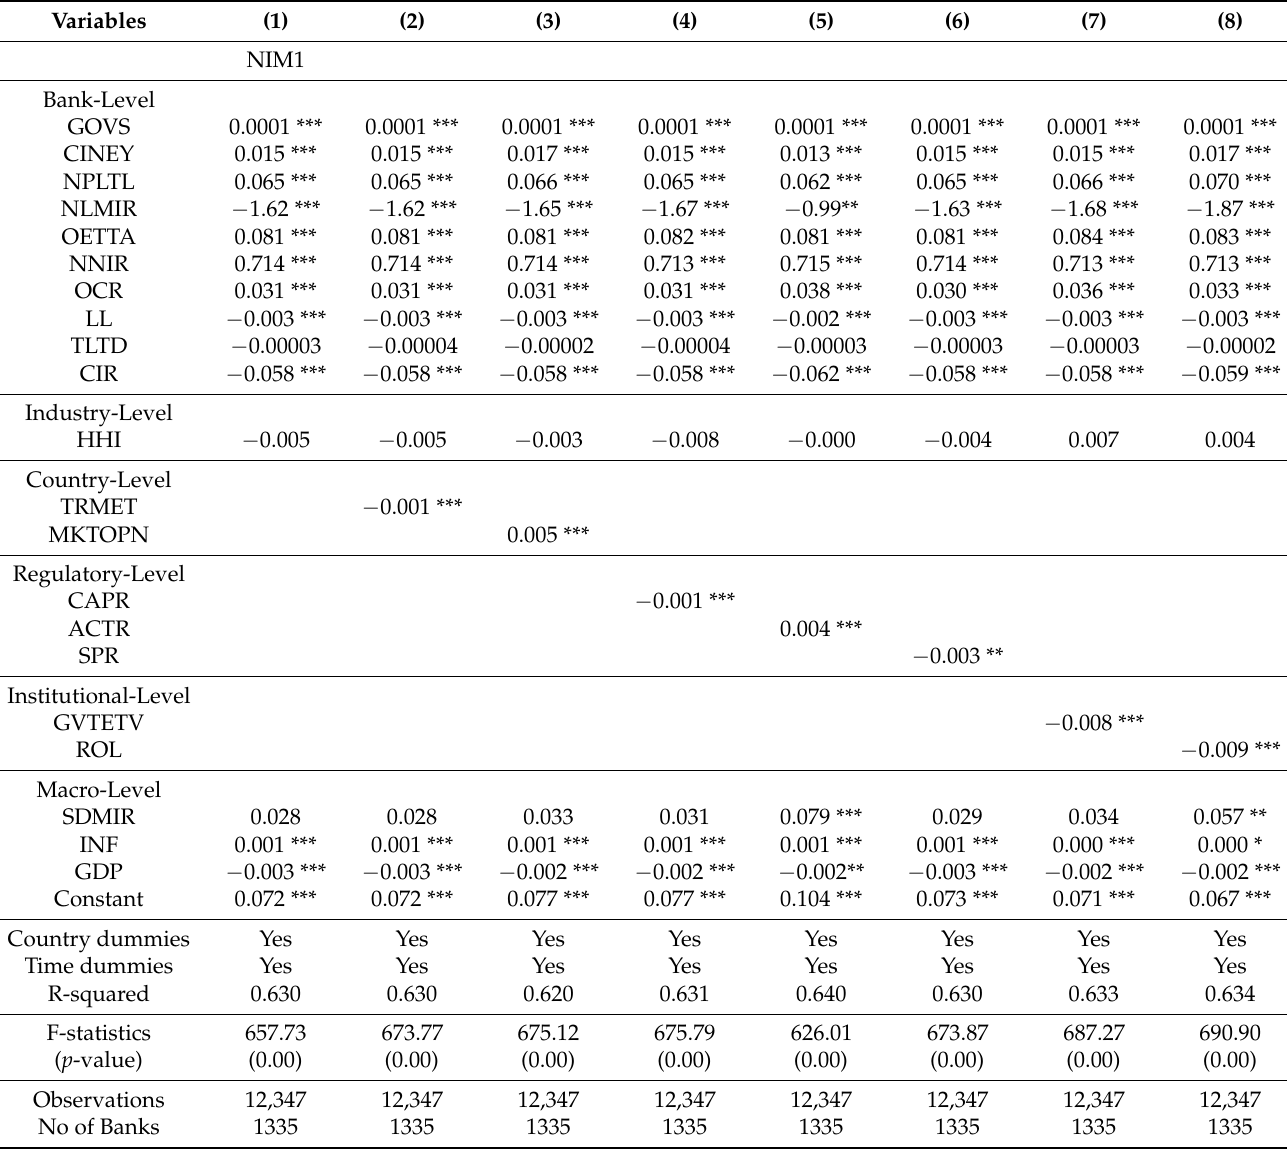
Table 10. Pooled panel OLS regression.